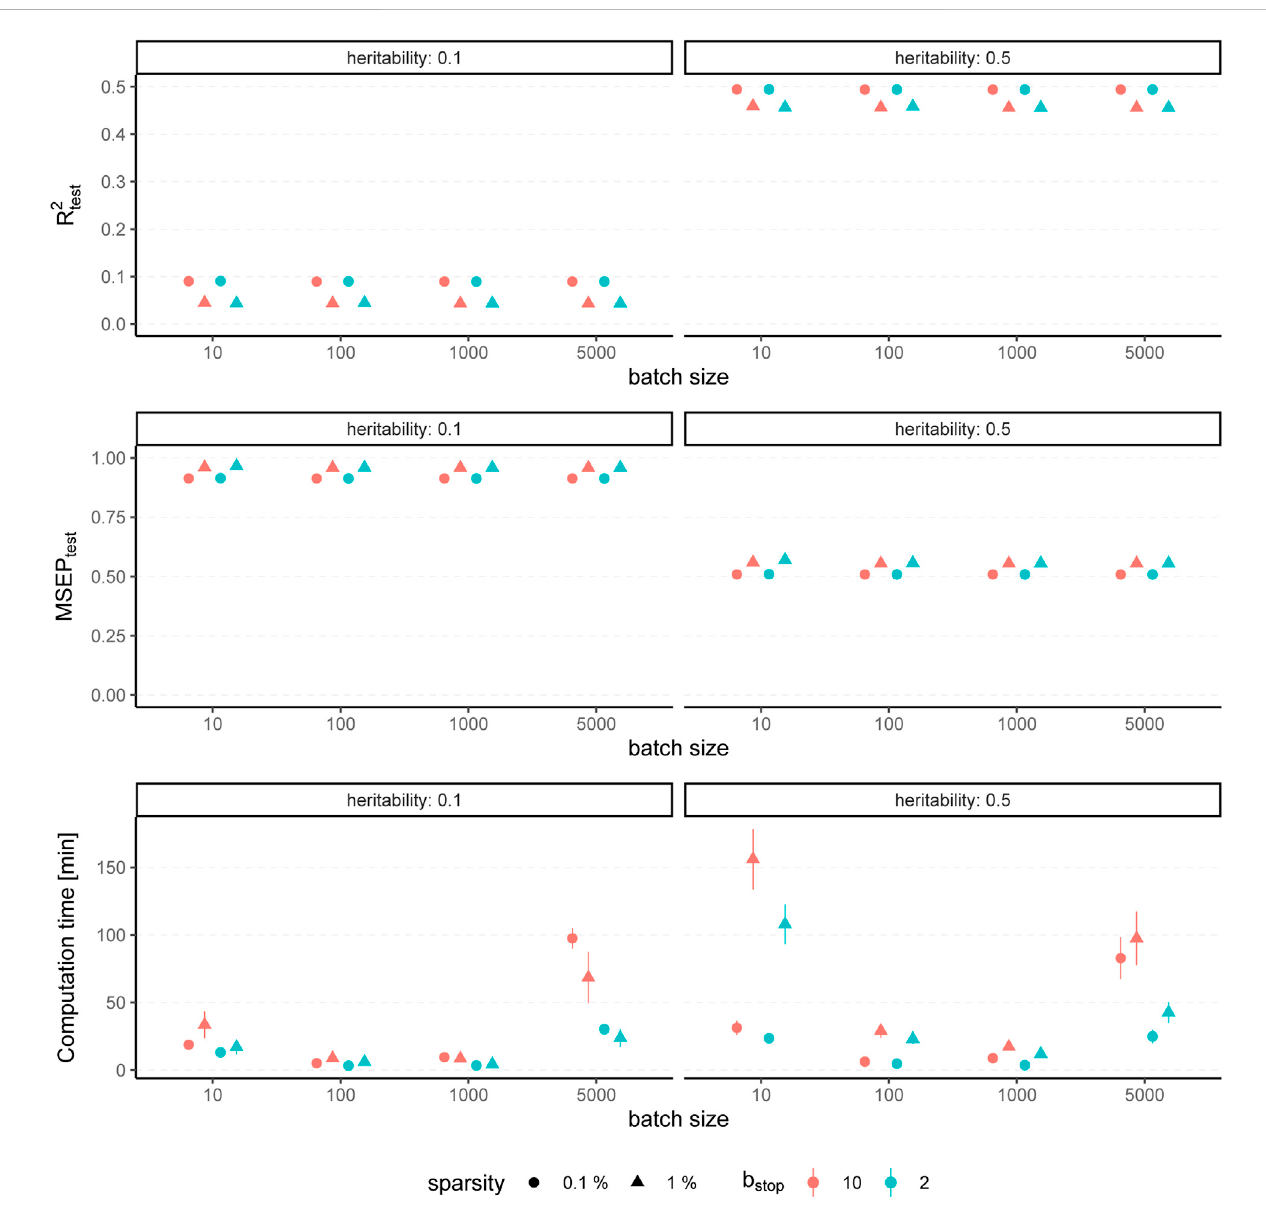
FIGURE 3 Predictive performance for varying batch size and stopping criteria. Results of 100 simulated phenotypes with heritability h 2 ∈ {10%, 50%}, sparsity s ∈ {0.1%, 1%} and b stop ∈ {2, 10} for p = 100, 000 variants and n = 100, 000 individuals (divided into 50% training, 20% validation and 30% test set). Mean and standard deviation of the evaluation metrics are shown depending on the batch